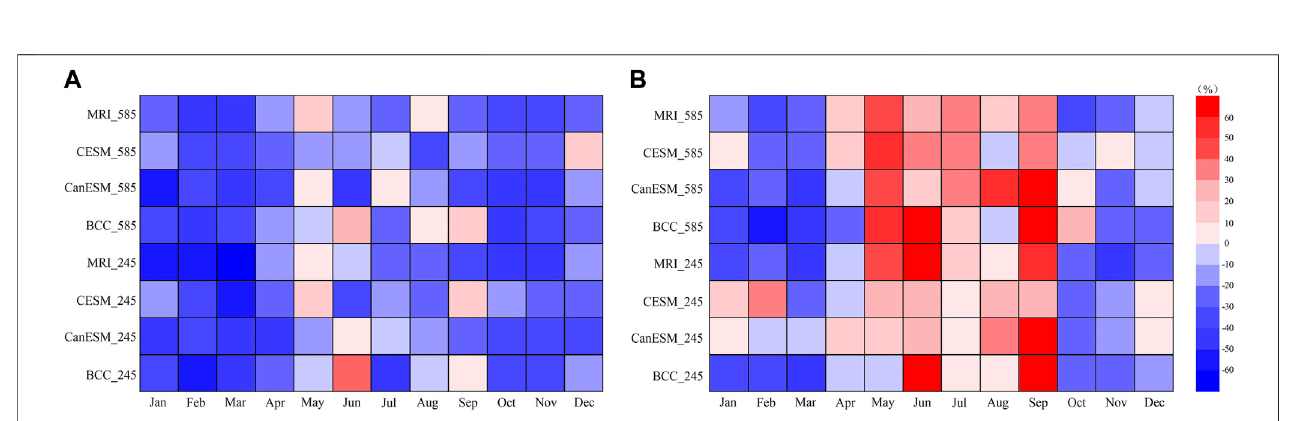
FIGURE 8 | Relative change results of seasonal runoffs during two future periods 2050s (A) and 2080s (B) to the historical period.